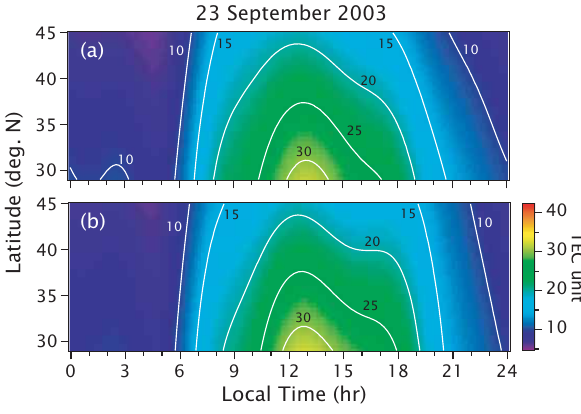
Fig. 5. Local time-latitude distribution of TEC; (a) predicted by trained NN for March equinox in 2003 and (b) mean TEC averaged over a 27-day period centered on March equinox 2003 constructed using gTEC data.